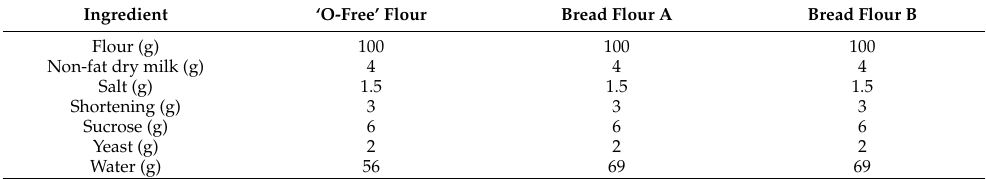
Table 1. Ingredients and formula for bread prepared with various flours by Method 10-10.03 with a minor